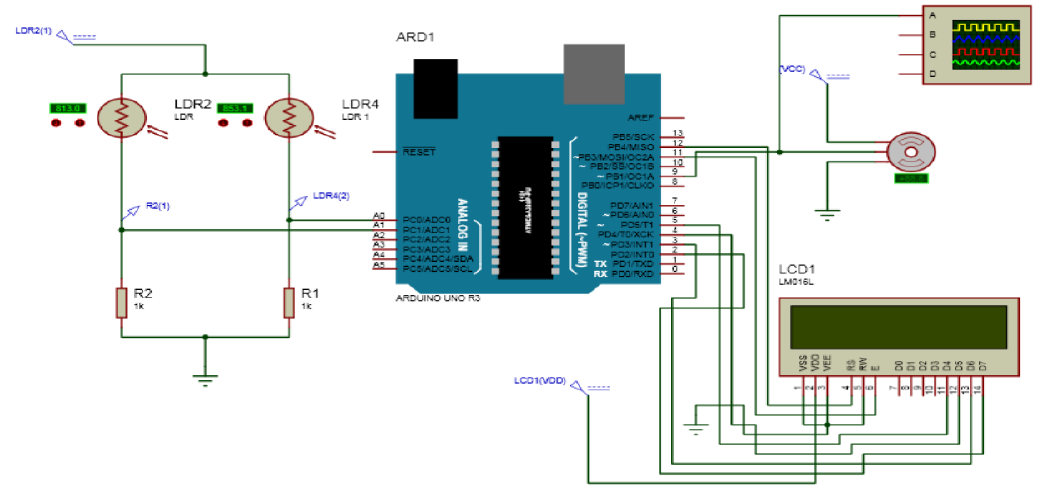
Figure 4. Block diagram used during simulation by ISIS.